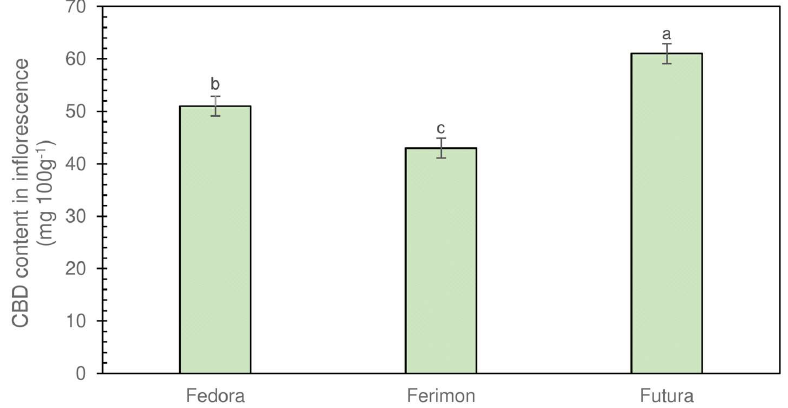
Figure 4. Cannabidiol (CBD) content in the inflorescences. Means with the same letter are not significantly different. LSD at 5% level. Bars represent standard error.